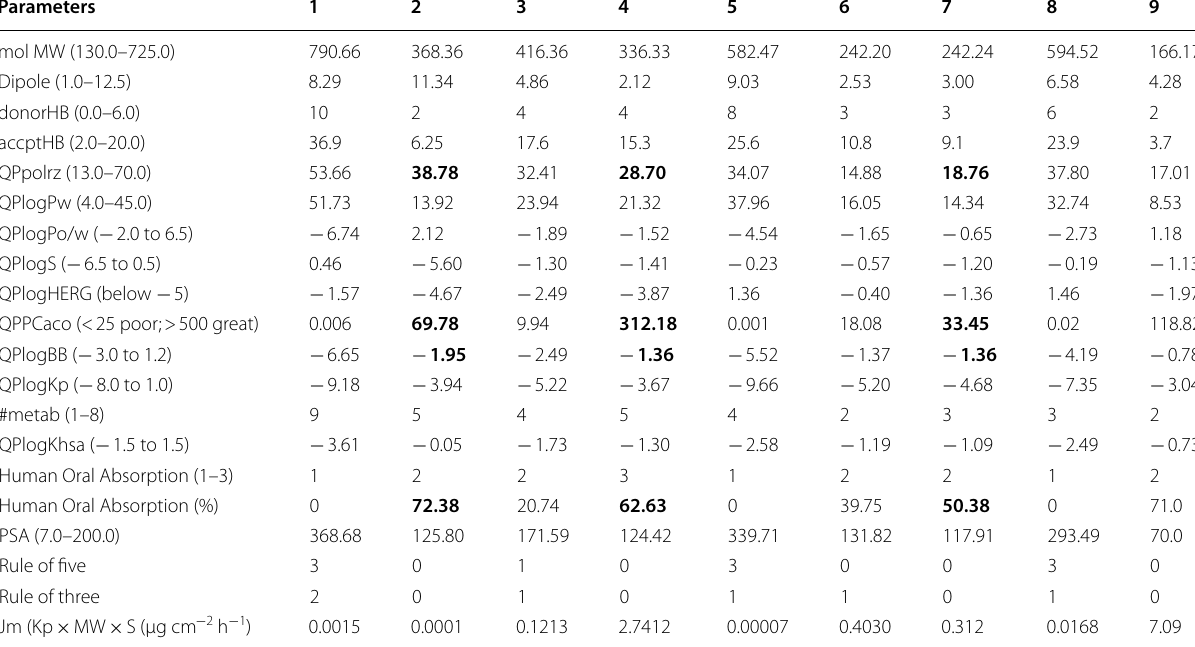
Table 2 ADMET profiling of nine compounds in comparison with Schrodinger’s QikProp module, where 1: κ-carrageenan, 2: carrageenan/MIV-150, 3: α-carrageenan, 4: β-carrageenan, 5: carrageenan-lambda, 6: 3,6-anhydro-2-(hydrogen sulfate)-alpha-D- galactopyranose, 7: fucoidan, 8: lambda-carrageenan, 9: 3-phenyllactate